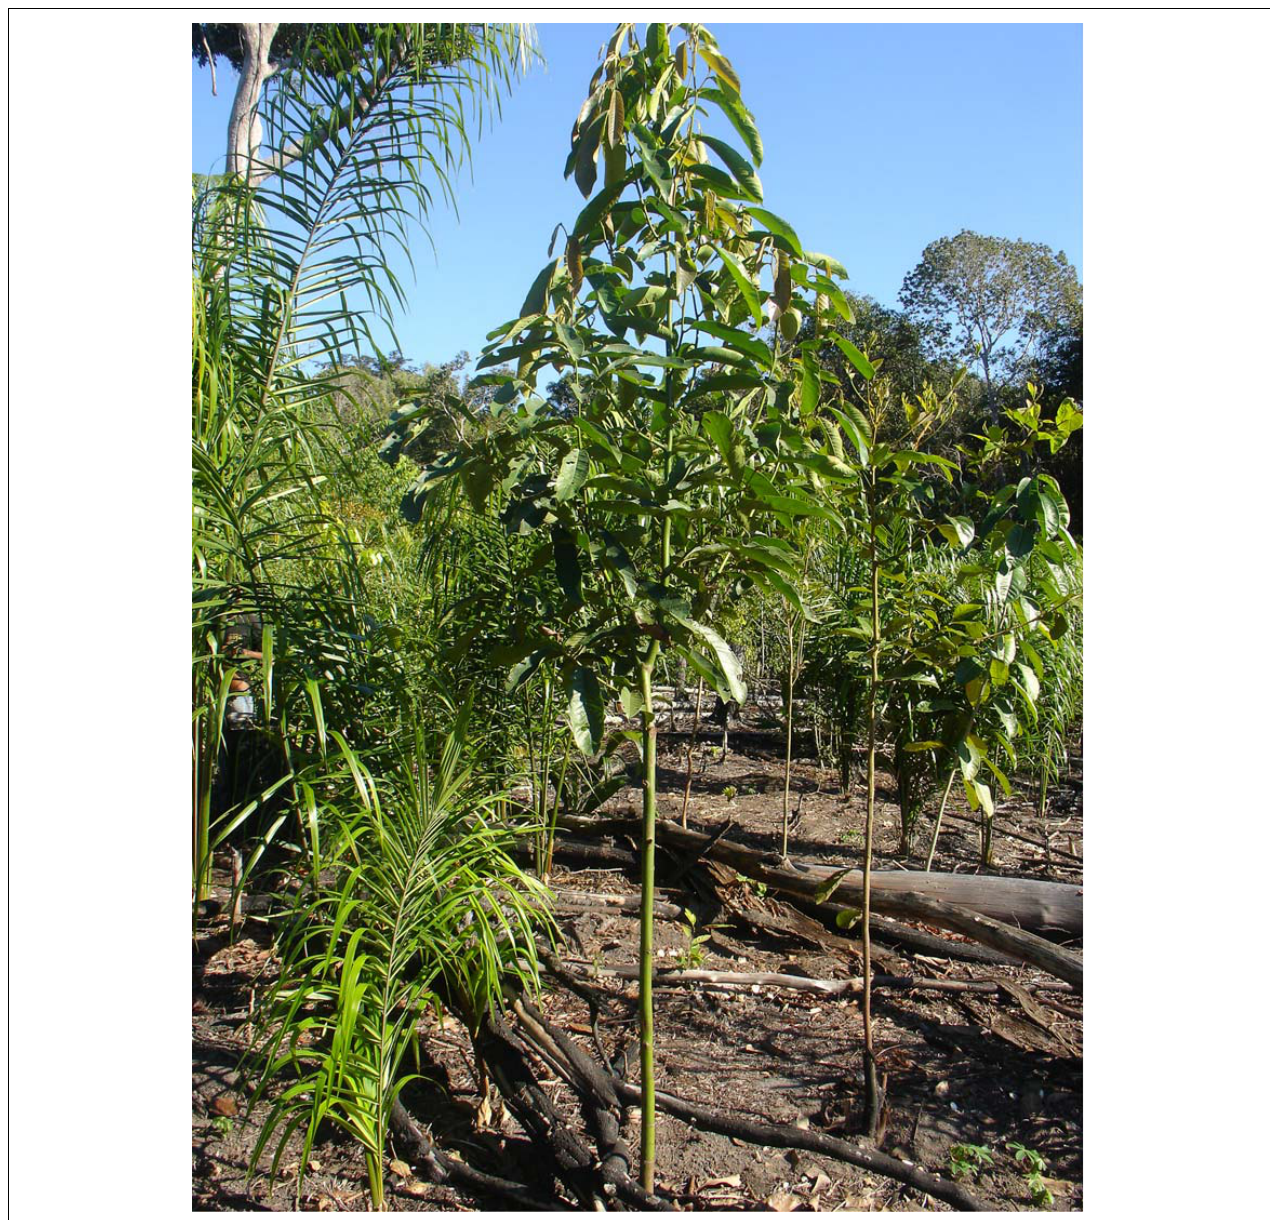
FIGURE 5 | Three-year-old cultivation plot ( ïrïnpïn ) submitted to selective cleaning management ( tukto tawengkeremtowo ) in Moygu village. See young trees that were left to grow for different purposes: medicinal— ( arakto (ni), ykwalapi (ni); construction— raegï ( Xylopya amazonica R. E. Fr.), mopya ( Attalea maripa (Aubl.) Drude); ritual— yepkuy ( Himatanthus sucuuba (Spruce ex Müll. Arg.) Woodson); food and food for hunting— motoe ( Helicostylis tomentosa (Poepp. and Endl.) J. F. Macbr.), food, food for hunting and ritual— inot ( Caryocar cf. Brasiliensis Cambess); among others ( Photo by Marcus V. C Schmidt, Moygu Village